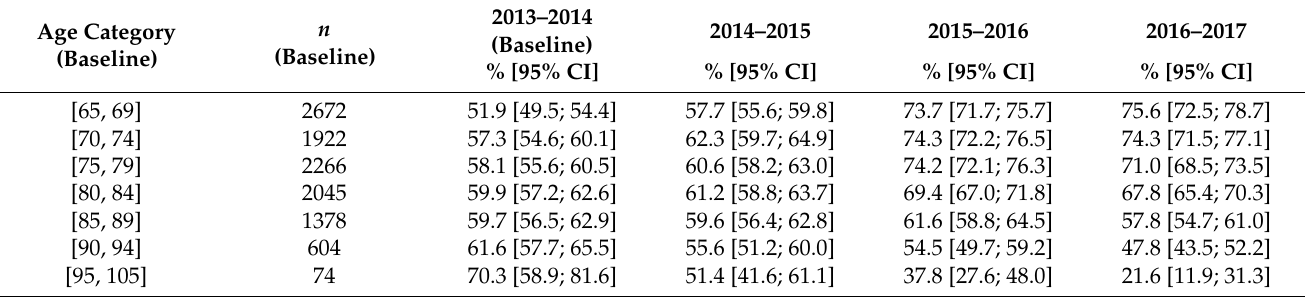
Figure 4. Influenza vaccination uptake by age at baseline < 65 group (with chronic condition). Table 5. Influenza vaccination uptake by age at baseline ≥ 65 group (with chronic condition).